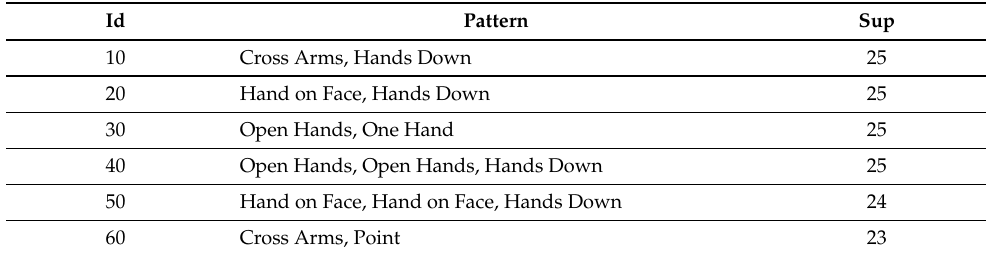
Table 8. Selected sequences from presentation 3 of year